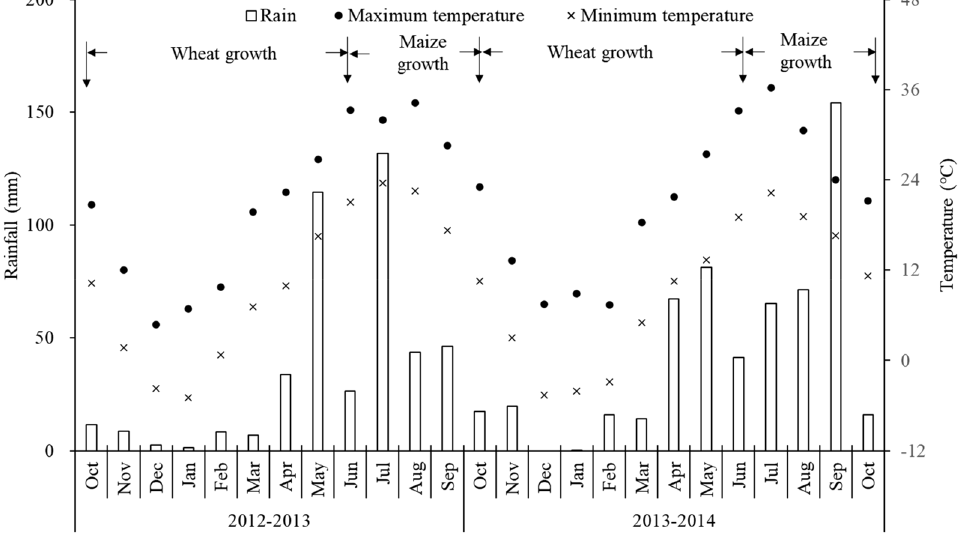
Figure 5. Monthly rainfall and mean temperature during crop growing